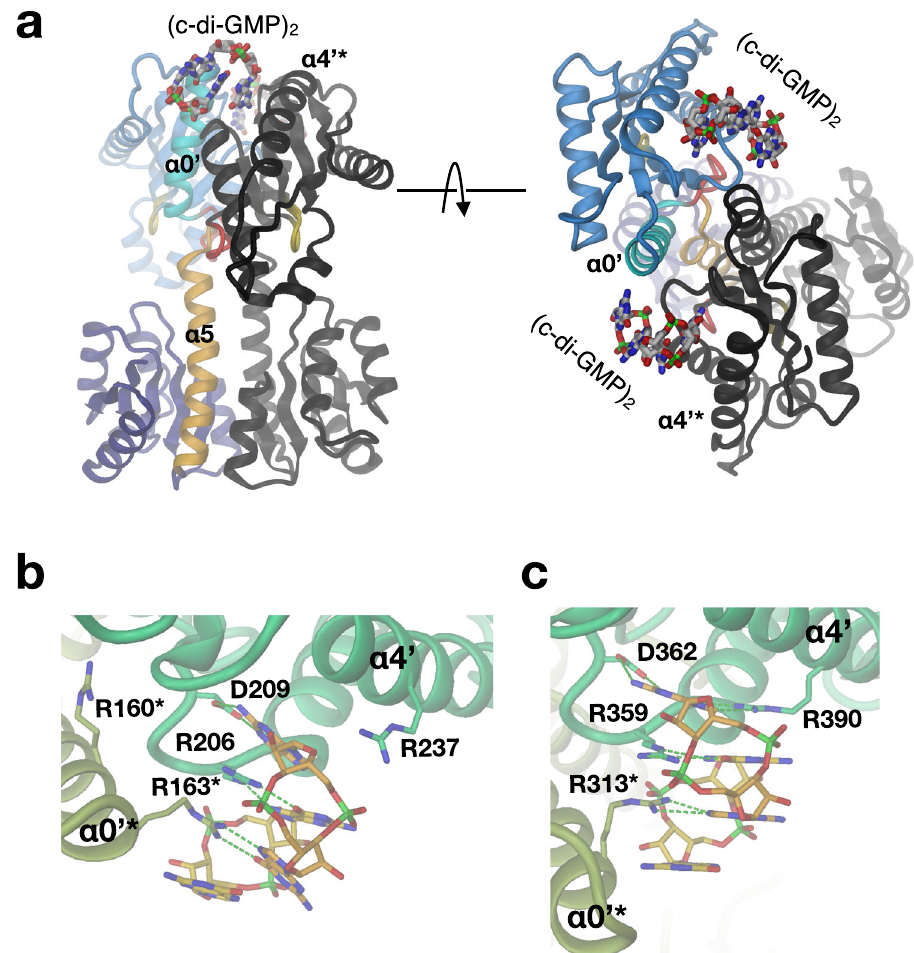
Fig. 8 Dimeric c-di-GMP cross-links the GGDEF domain of the dimer. a Side and top views of the DgcR/c-di-GMP complex (DgcR_inh). Representation as in Fig. 1b. b , c Detailed comparison of the c-di-GMP binding mode in DgcR ( b ) and PleD (2V0N) ( c ). Protomers are distinguished by colour hue. H-bonds are shown as green broken